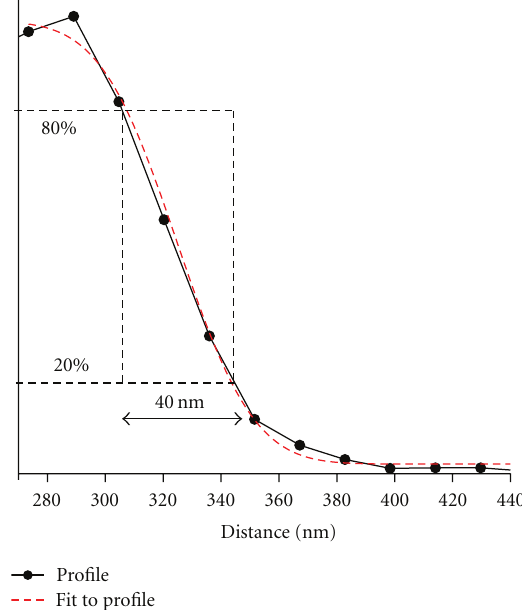
Figure 11: Enlargement of part of the profile from Figure 9 showing a superimposed fit of a complementary error function and the 20% and 80% points. The inferred spot size for the FIB beam (and so the spatial resolution of the SIMS signal) is between 40 and 50 nm for this